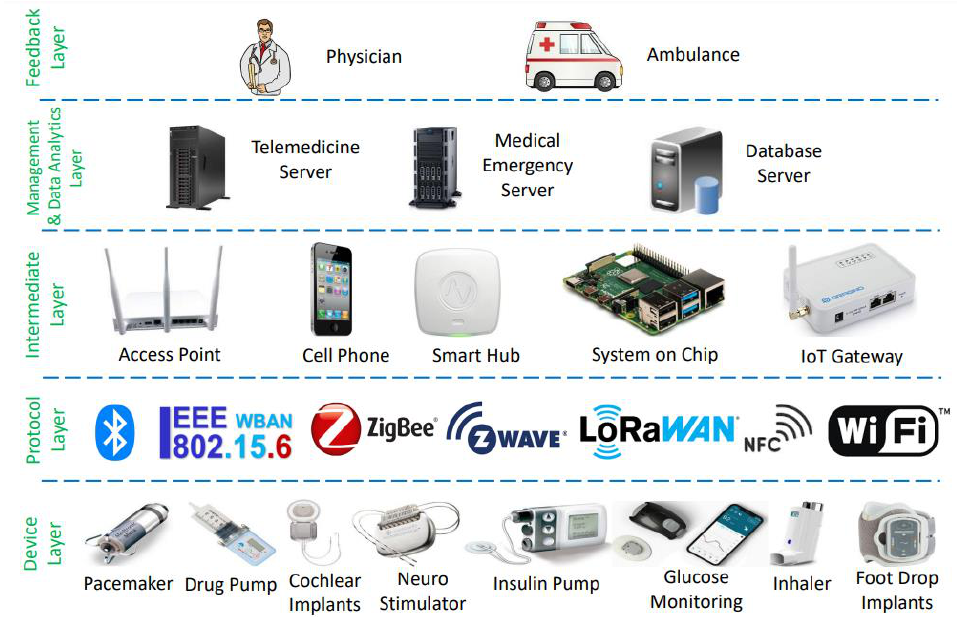
Figure 3. Five-Layer Architecture for IoHT.